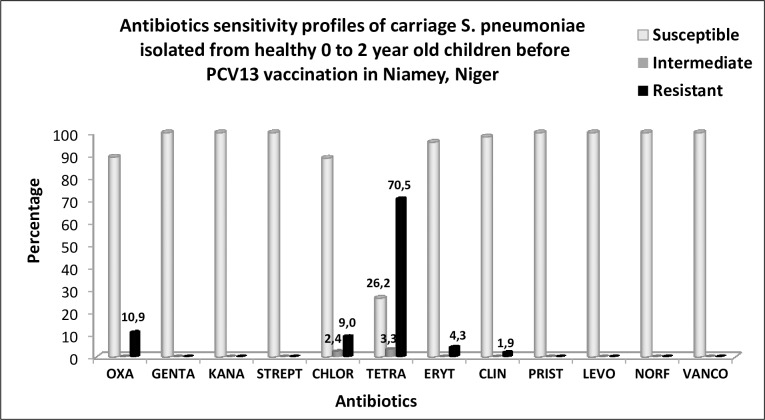
Antibiotic sensitivity profile of pneumococcal carriage isolates detected from healthy, 0 to 2 year old children before PCV13 start in Niamey, Niger.Legend: OXA: oxacillin, GENTA: gentamycin, KANA: kanamycin, STREPT: streptomycin, CHL: chloramphenicol, ERY: erythromycin, TET: tetracycline, CLIN: clindamycin, PRIST: pristinamycin, LEVO: levofloxacin, NORF: norfloxacin, VAN: vancomycin.